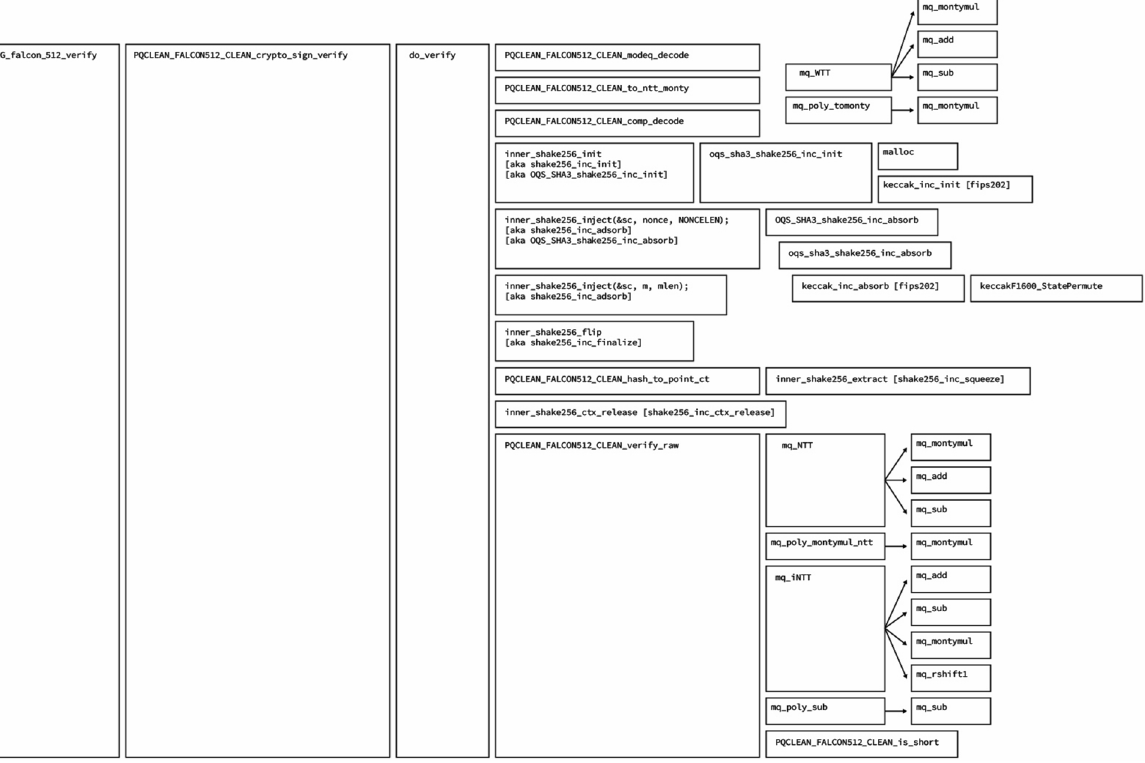
Figure 9. High level function hierarchy of Falcon highlighting the necessary calls for